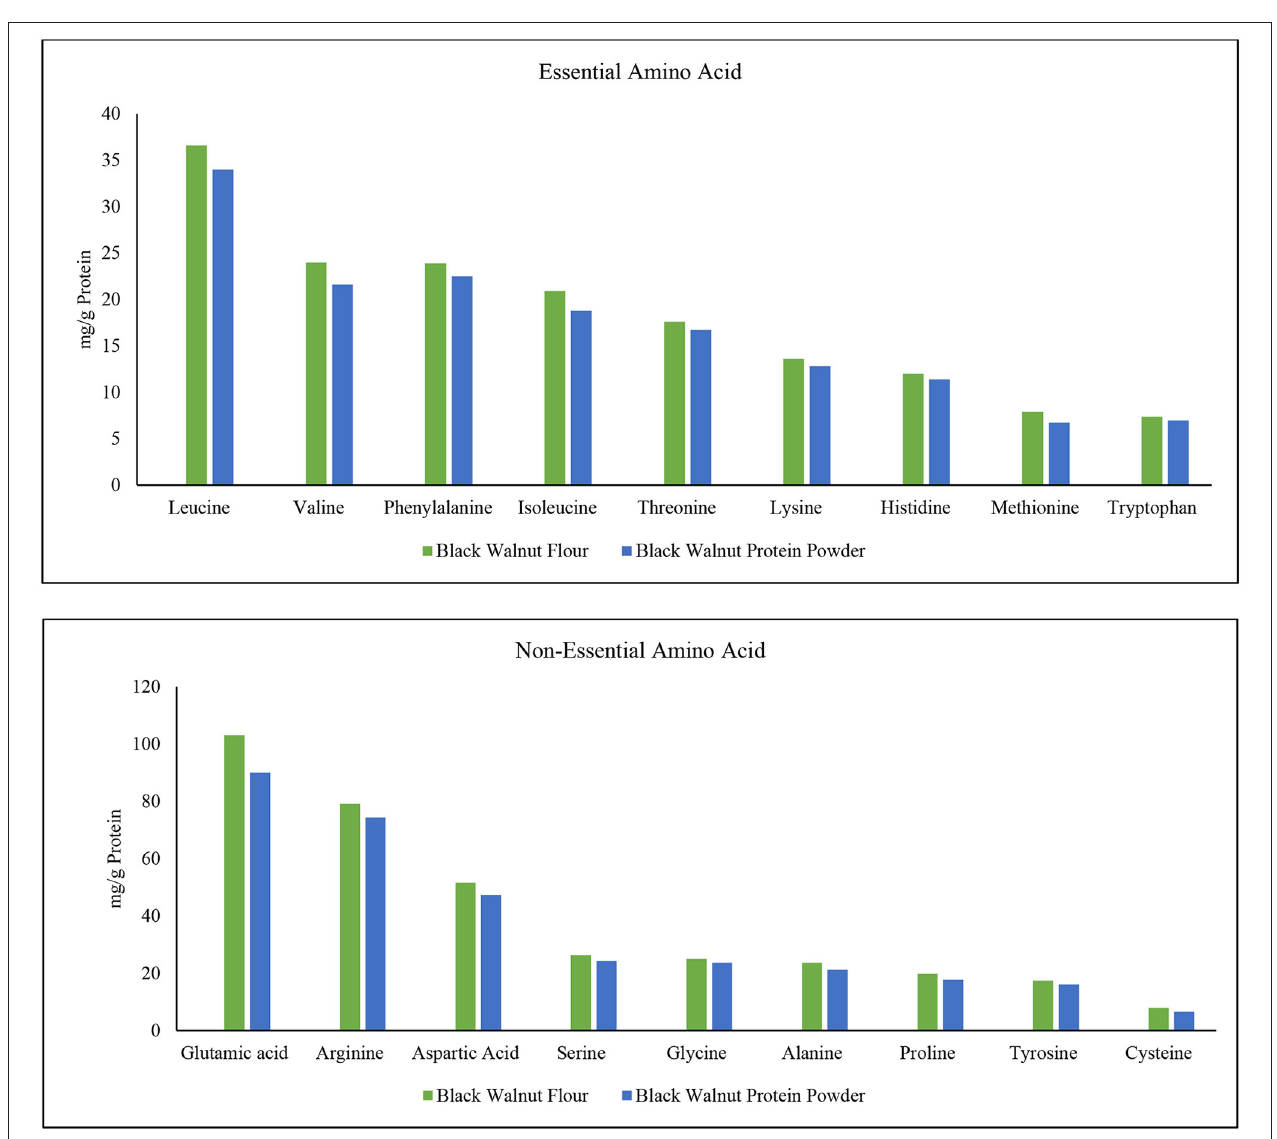
FIGURE 5 | Essential and non-essential amino acid composition in black walnut flour (Lab-1) and black walnut protein powder